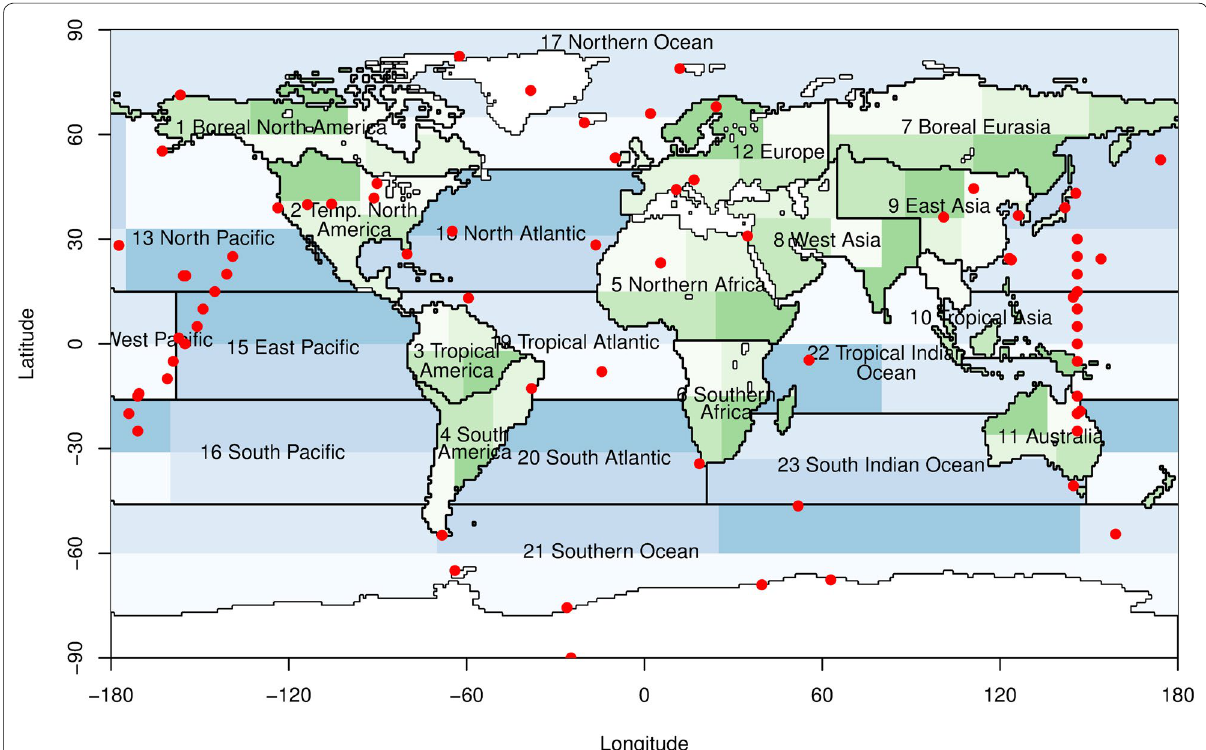
Fig. 1 Maps of CO 2 inversion regions (54 land and 30 ocean; shaded ) and atmospheric observation network ( circle ) with mostly surface sites, except for the Japan AirLines (JAL) flight track between Tokyo and Sydney/Brisbane. The snow-covered (zero flux) Antarctica and Greenland are not opti- mized by the inversion system. The CH 4 inverse model solves for emissions from 53 land only regions (1 region less in the Southeast Asia; ref. Patra et al.